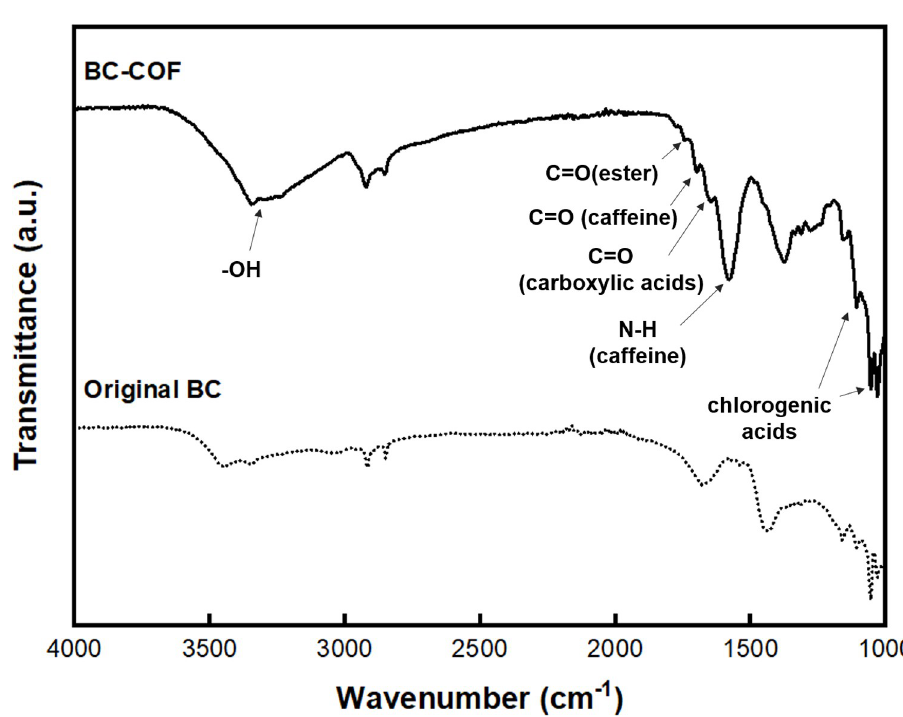
Fig 5. FT-IR spectra of original BC and BC-COF bio-leather (Extraction conditions: Liquor ratio of 1:10 (w/v), coffee at an amount of 200 wt% BC, 90˚C, 1 h; dyeing conditions: Fabric-to-liquor ratio of 1:10 (w/v), 70˚C, 30 min, meta-mordanting with 1% of FeSO 4 ).